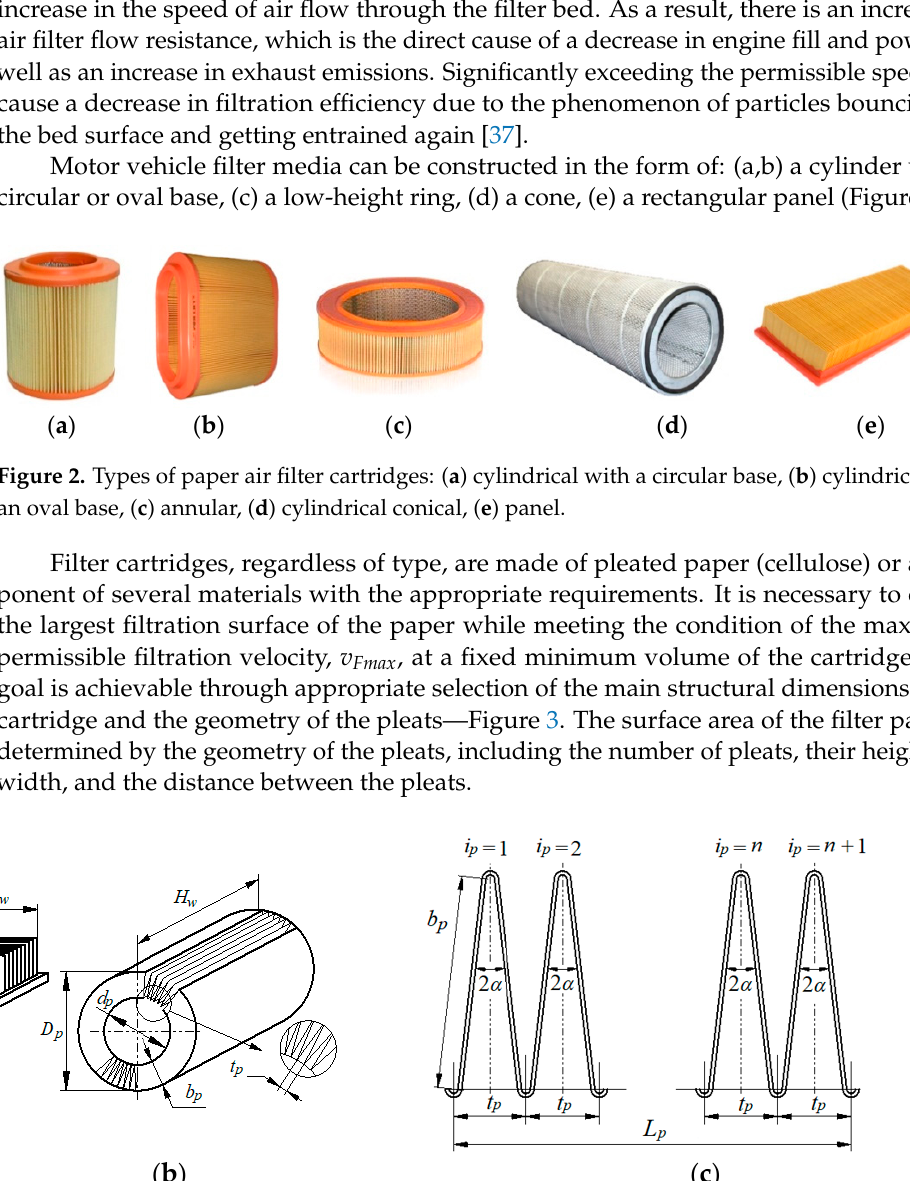
Figure 3. Geometry of the filter bed: ( a ) panel cartridge, ( b ) cylindrical cartridge, ( c ) pleat geometry. L p —the length of the cartridge, a w —the width of the pleat, b p —the height of the side of the pleat, t p —the pitch of the pleat (the gap between the pleats), D p —the outside diameter of the cartridge, H w —the height of the cartridge, α —the angle of the half pleat.